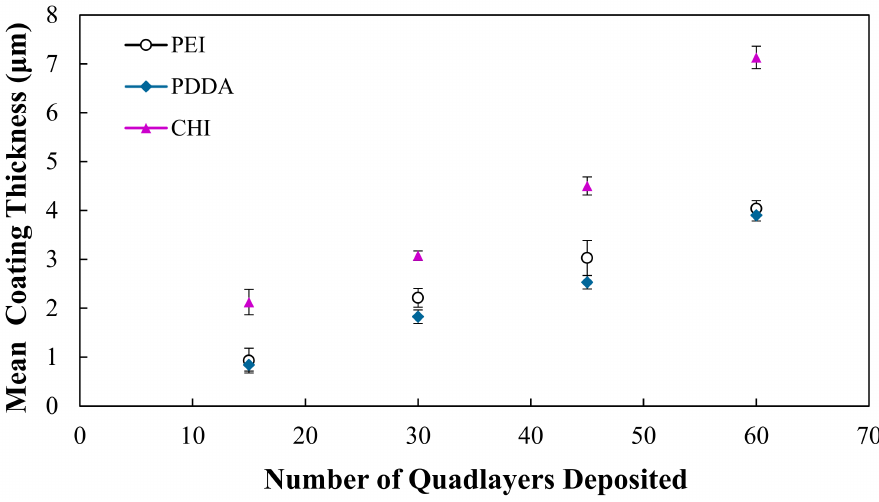
Figure 1. Mean coating thicknesses of PEI, PDDA and CHI coatings assembled with 15, 30, 45 and 60 QLs on glass microscopic